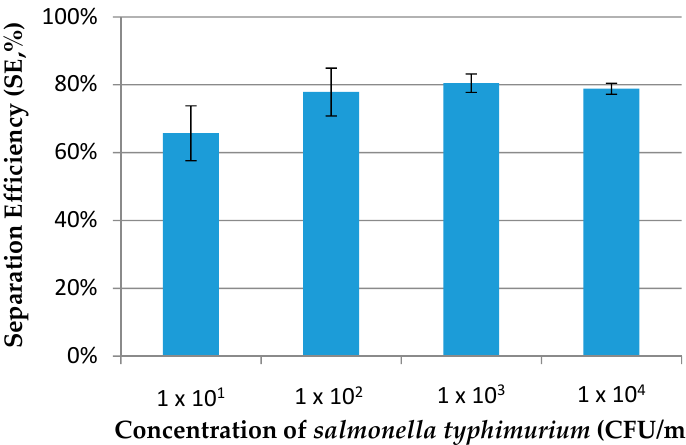
Figure 5. Separation efficiency of salmonella typhimurium at concentrations from 10 1 to 10 4 CFU/mL using the proposed device with a flow rate of 50 μ L/min ( N = 3).